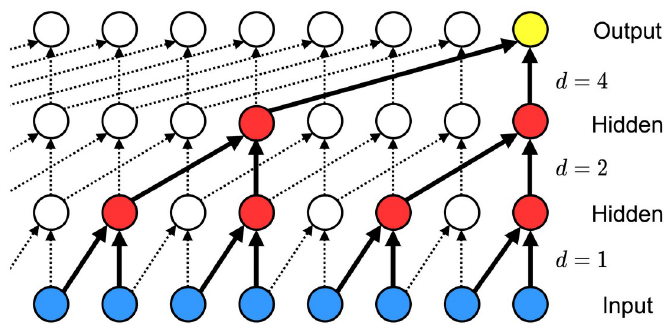
Fig 3. TCN architecture. A temporal convolutional network with layers corresponding to exponentially increasing dilation factors d = 1, 2, 4. The blue circles correspond to an input layer, the red circles correspond to hidden layers, and the yellow circles correspond to an output